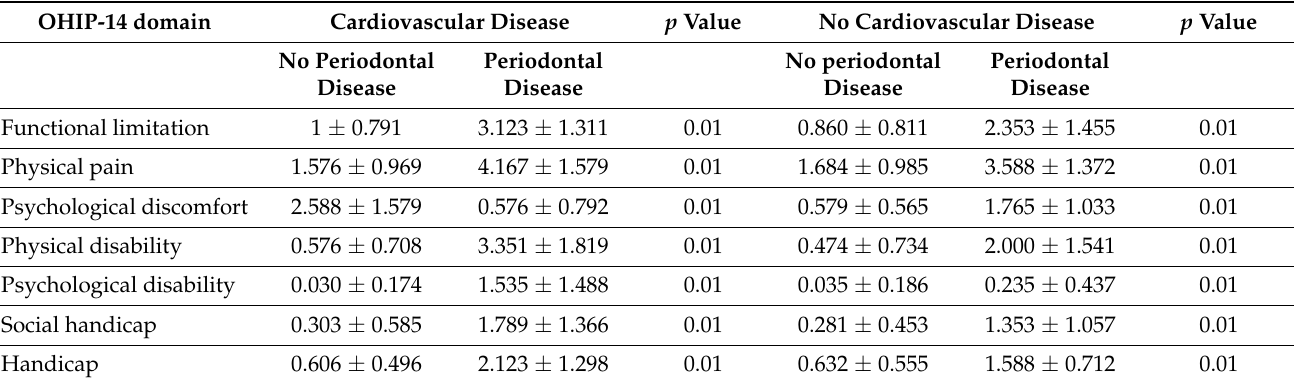
Table 6. Average OHIP-14 domain scores in patients with and without cardiovascular disease.